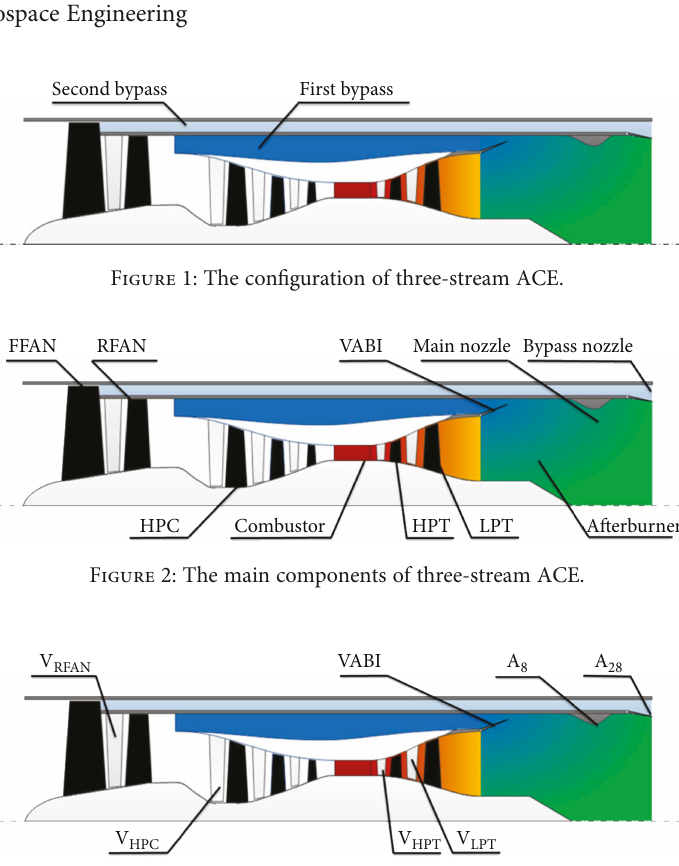
Figure 3: The available variable geometries of three-stream ACE.